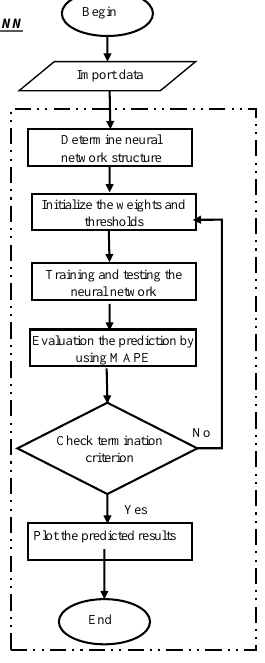
Figure 2. The flowchart of ANN model.